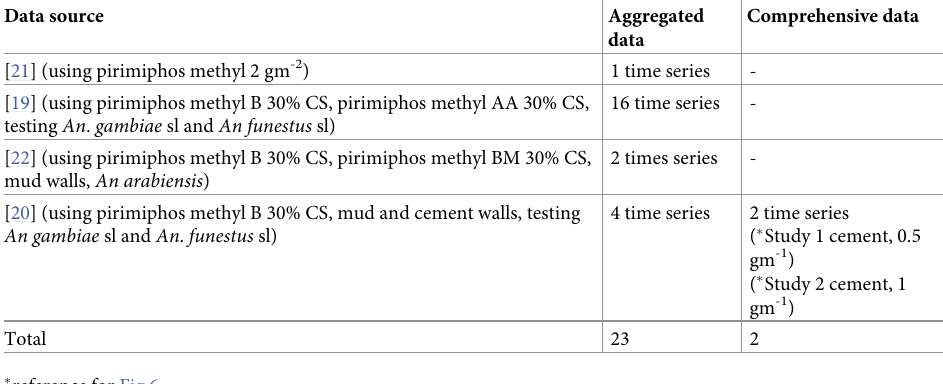
� reference for Fig